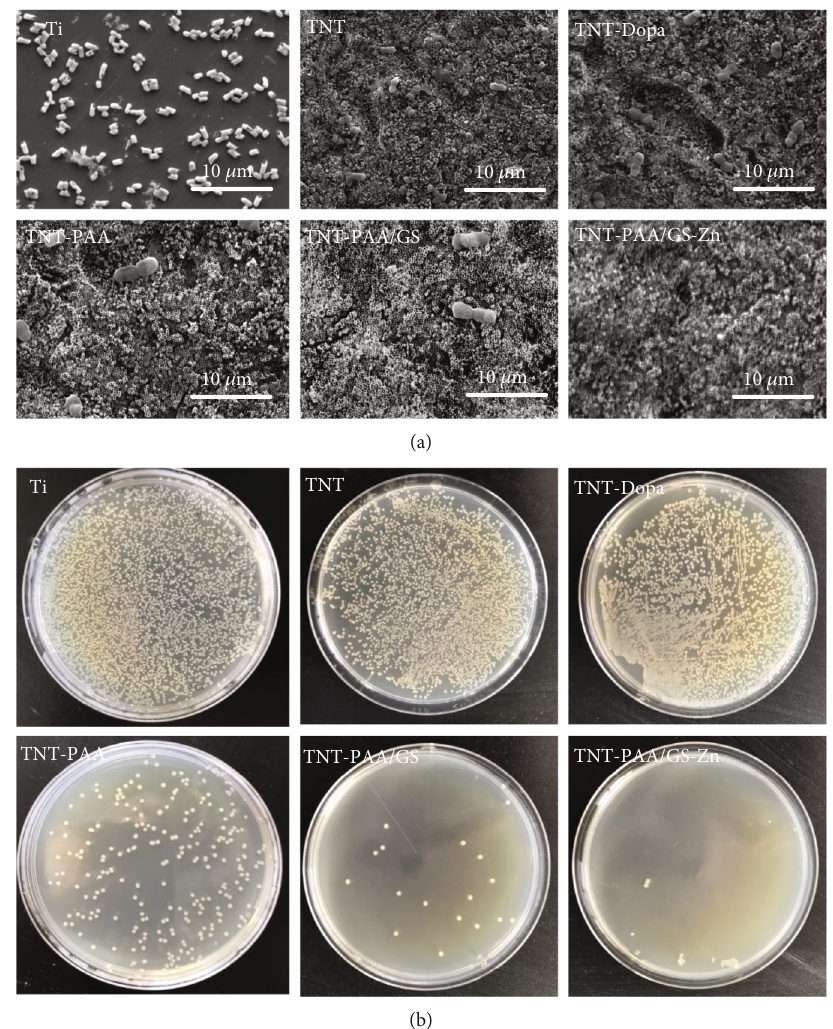
Figure 6: The bacterial adhesion (a) and antibacterial properties (b) of the di ff erent